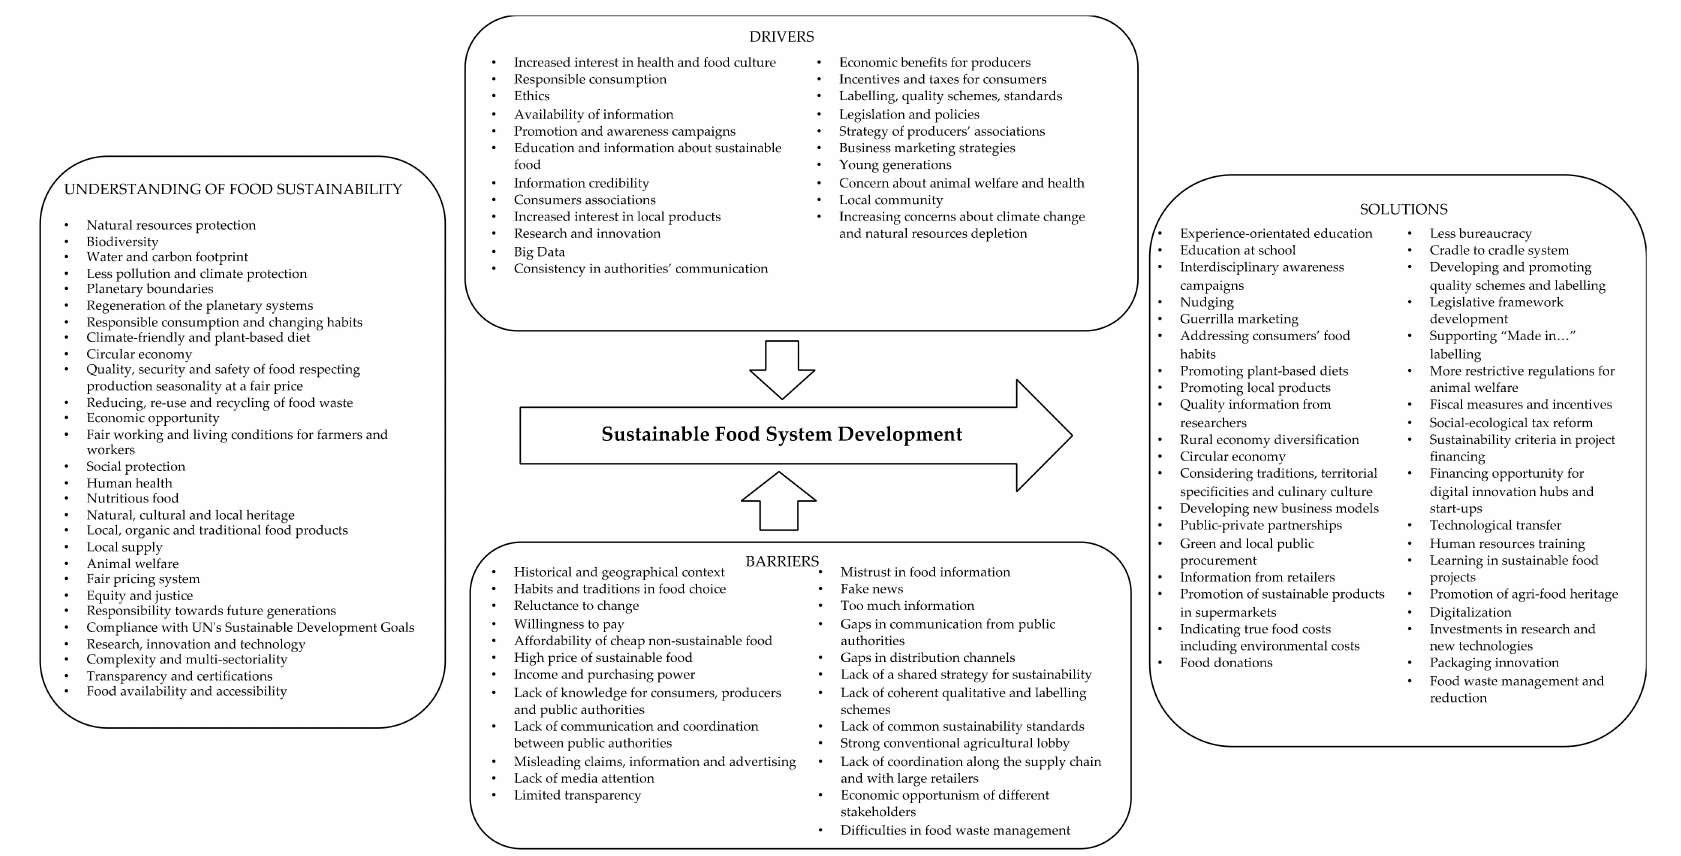
Figure 2. Understanding of, barriers to, drivers for, and solutions for SFS development identified by stakeholders in the four investigated